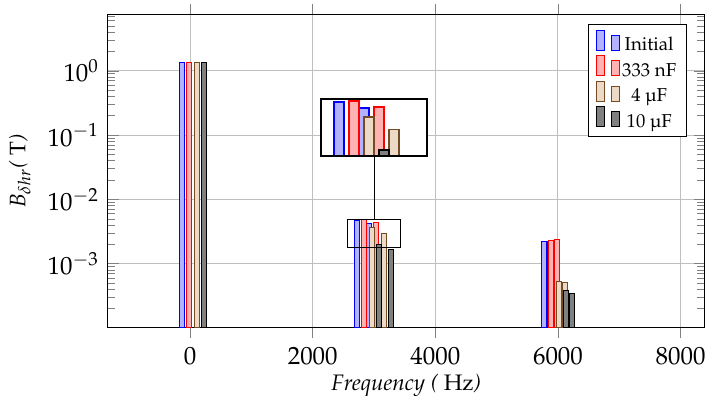
Figure 8. Radial flux density spectra ( B δ hr ); initial system and with different capacitors C a in the damper.